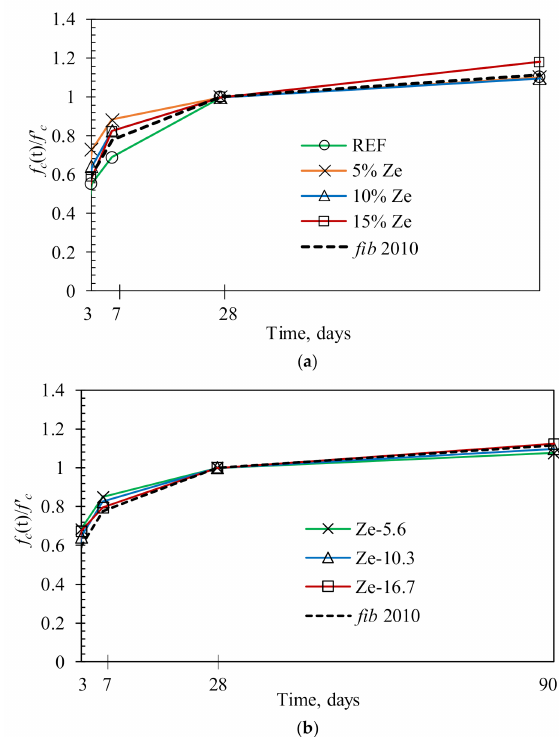
Figure 8. E ff ect of the zeolite content ( a ) and the particle size of zeolite ( b ) on the compressive strength development of HPC